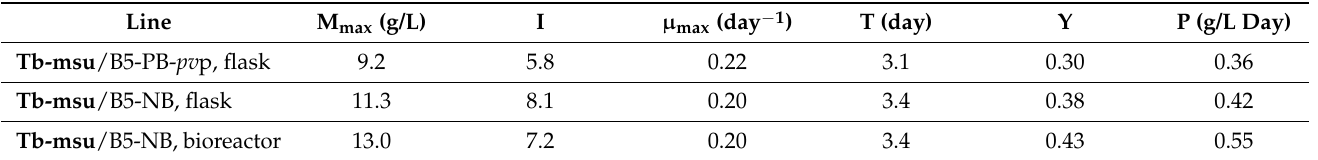
Table 2. Growth characteristics of the suspension cell cultures of Taxus baccata grown in 250-mL flasks and 20-L